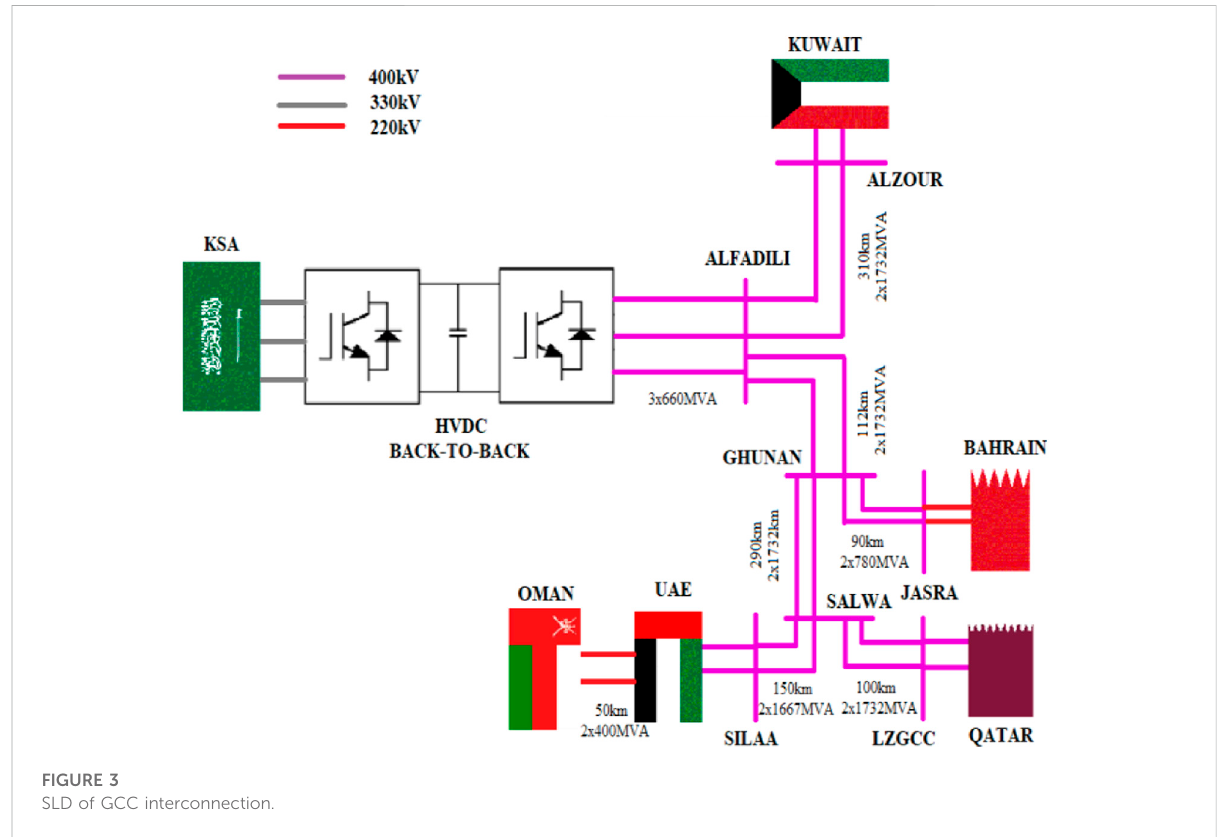
FIGURE 3 SLD of GCC interconnection.